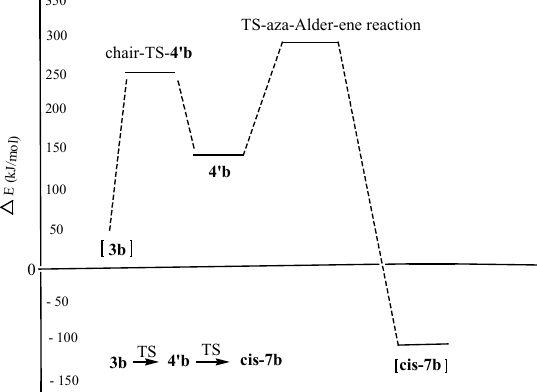
Figure 2. Energy diagram of the aza-Claisen rearrangement followed by aza-Alder-ene reaction.